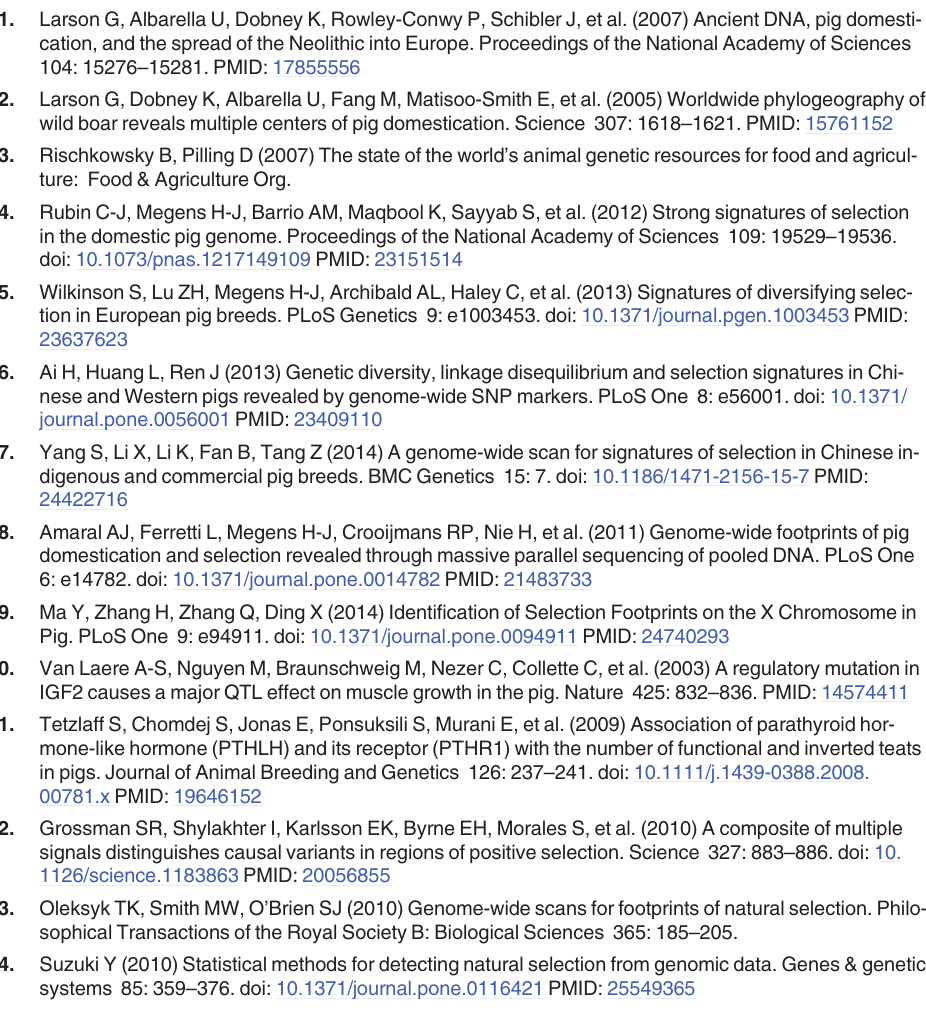
S9 Fig. Genome map of candidate selection regions in four pig Breeds. (TIFF) S1 Table. The complete list of genes and QTLs overlapping with candidate selection regions in four pig